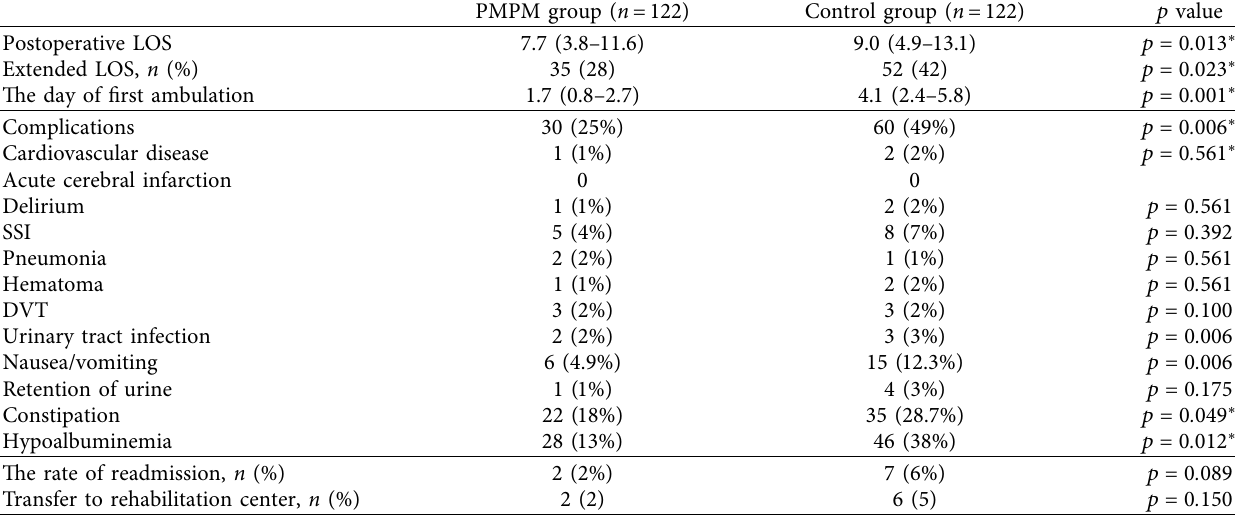
Table 4: Other outcomes of the two